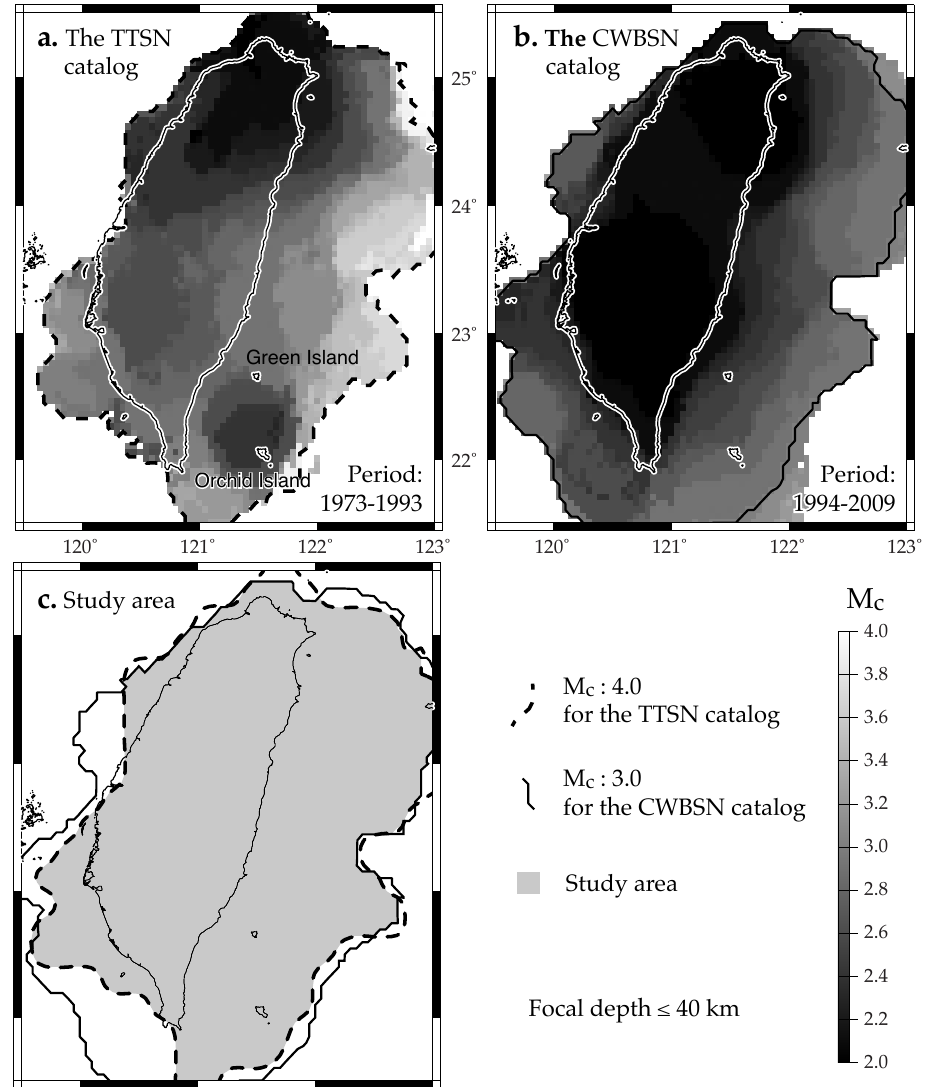
Fig. 2. The magnitude of completeness ( M c ) for (a) the TTSN and (b) the CWBSN catalogues within the time window from 1973 to 1993 and from 1994 to 2009, respectively, for shallow earthquakes (with a focal depth ≤ 40km). (c) The study area, which is the intersection of regions with M c ≤ 4 . 0 for the TTSN (the dashed lines) and M c ≤ 3 . 0 for the CWBSN (solid lines), shown in gray. Note that a lower M c between Green Island and Orchid Island for the TTSN catalogue can be attributed to an additional station at Green Island. During the CWBSN period, the CWB did not install an instrument at Green Island and caused the